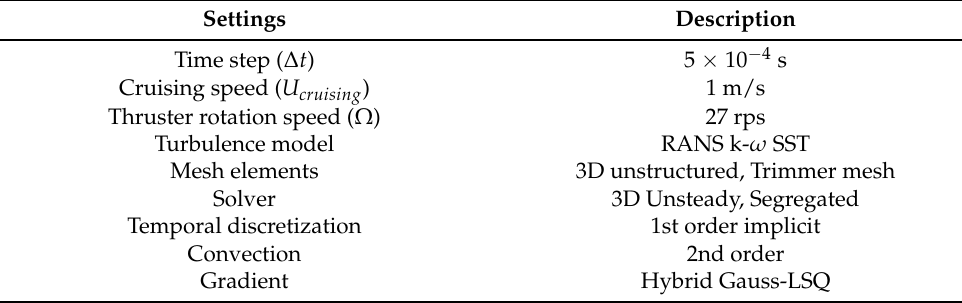
Figure 5. Mesh configuration around the thruster. Table 2. Numerical settings for flow noise